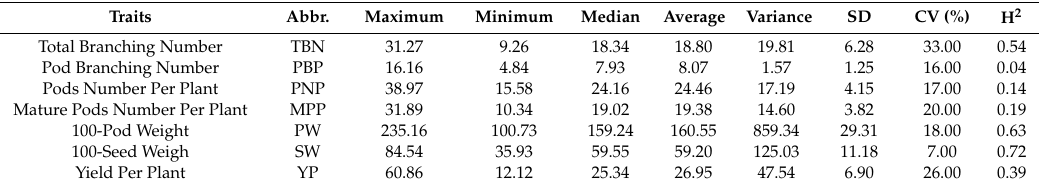
Figure 3. The frequency distribution of the studied peanut yield-related traits. Table 1. Phenotypic statistics of peanut yield-related traits.